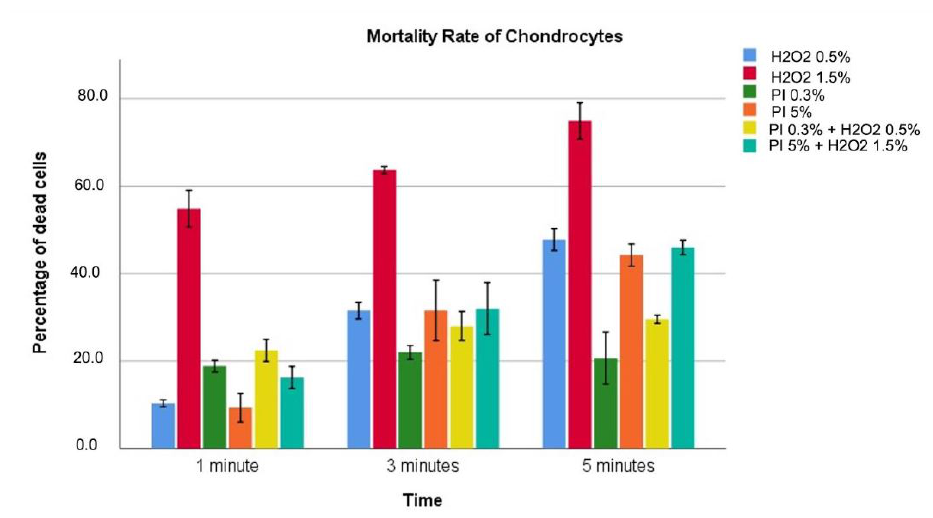
Figure 1. Different colors indicate different solutions. The height indicates the percentage of dead cells for the highlighted solution at that specific exposure time associated with 95%CI.